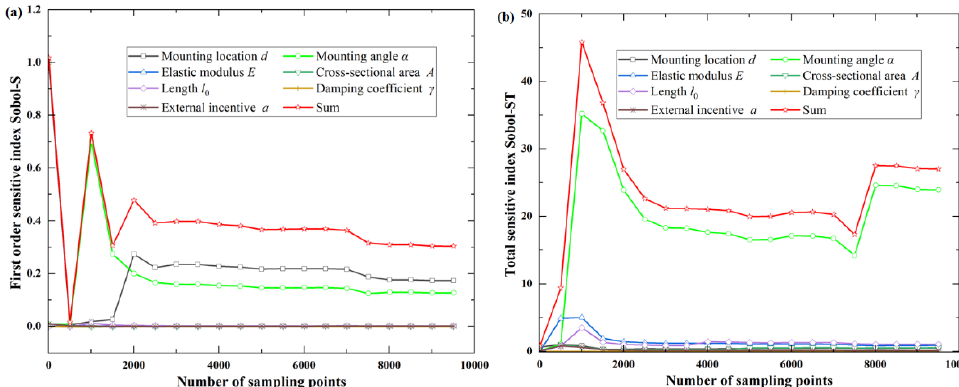
Figure 4. First-order and total sensitive index for objective function f 2 ( X ): ( a ) first-order sensitive index Sobol − S; ( b ) total sensitive index Sobol − ST.